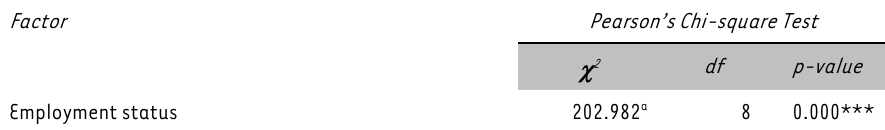
TABLE 5: Analysis of effect of employment status on household net equity quintile